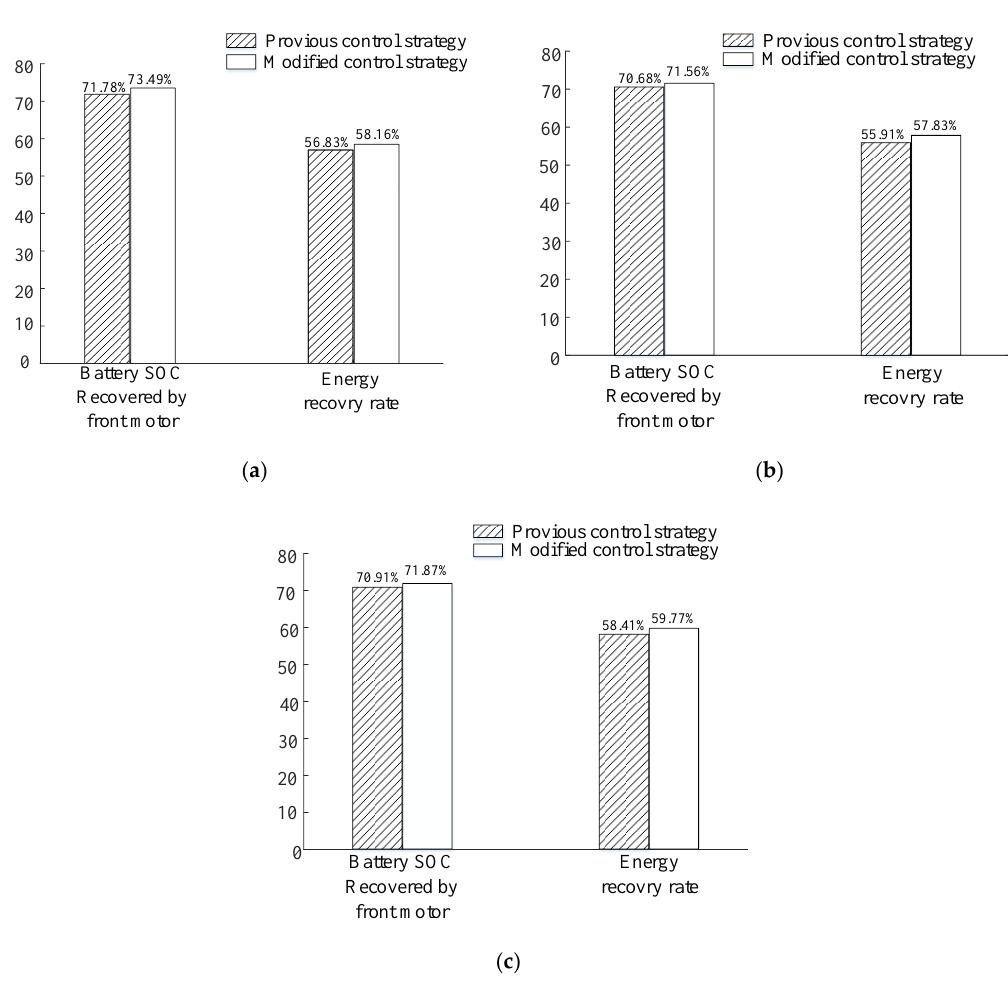
Figure 18. Front motor operating points during regenerative braking under UDDS.